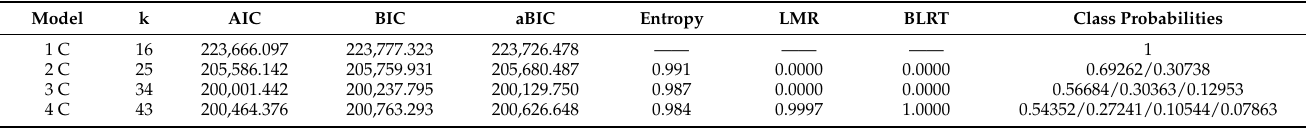
Table 5. Summary of fitting information of latent category analysis.